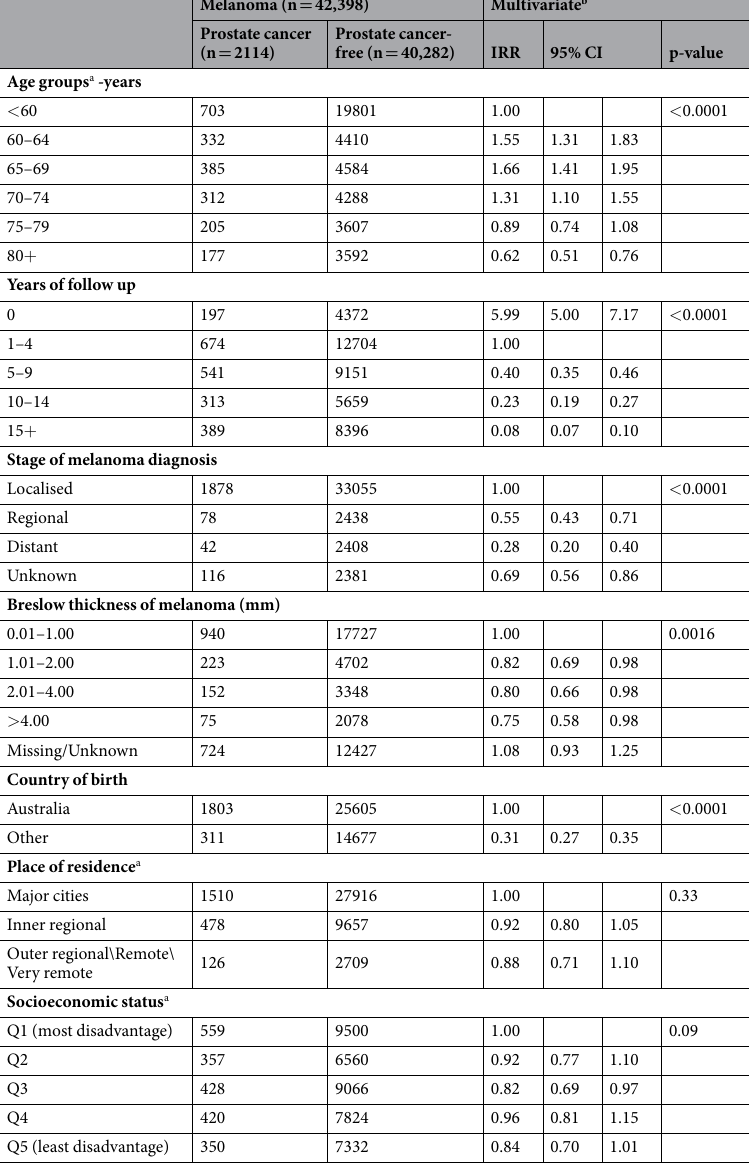
Table 2. Incidence rate ratio (IRR) and the 95% CI, for factors associated with prostate cancer risk for all cutaneous melanoma cases diagnosed between 1972 and 2008 in the New South Wales population. a Status when diagnosed with cutaneous melanoma. b Regression analysis adjusted for age of melanoma diagnosis, follow-up years, stage of melanoma, country of birth, place of residence and socioeconomic